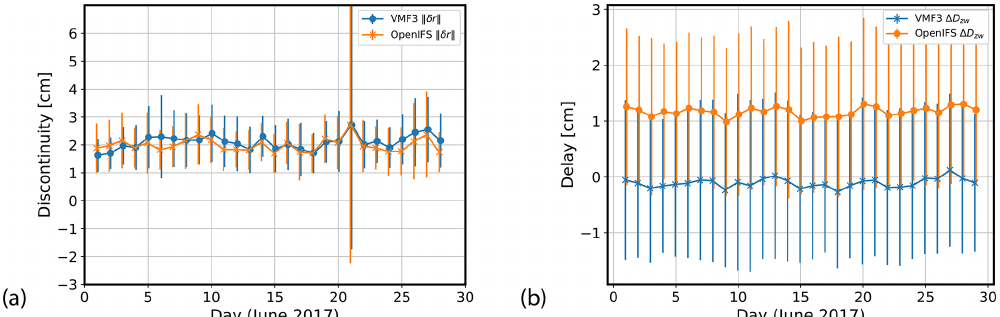
Figure A1. Daily means of (a) the midnight discontinuities and (b) the fitted zenith wet delays ( (cid:49)D zw ) of the default model (blue) and the experiment model (orange) for the month of June